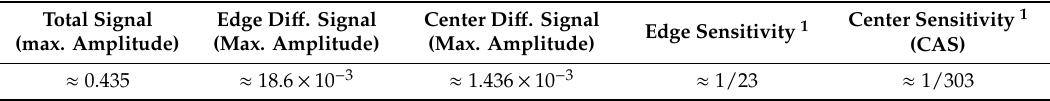
Table 1. Main results from the calculated signals, shown in Figure 5.